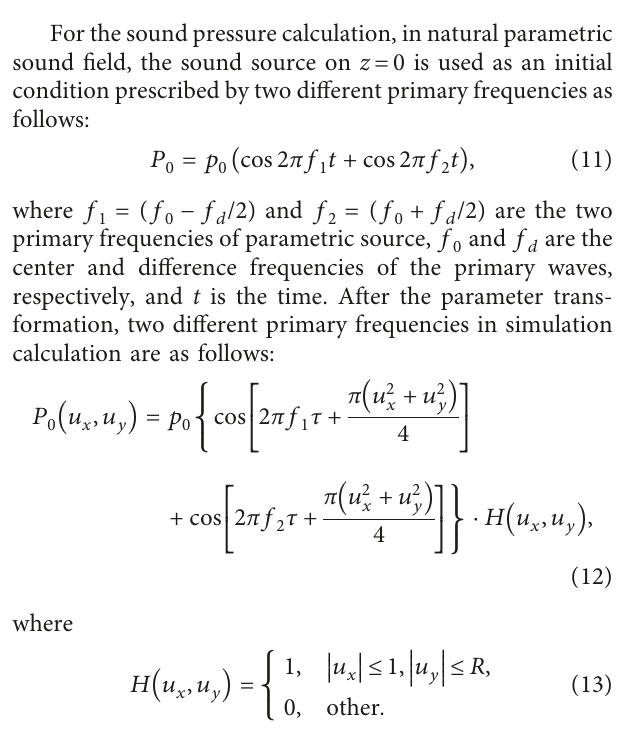
Figure 1: Schematic diagram of nonlinear acoustic propagation under inclined incidence conditions. (a) Cartesian rectangular coordinates. (b) Dimensionless transformed coordinate